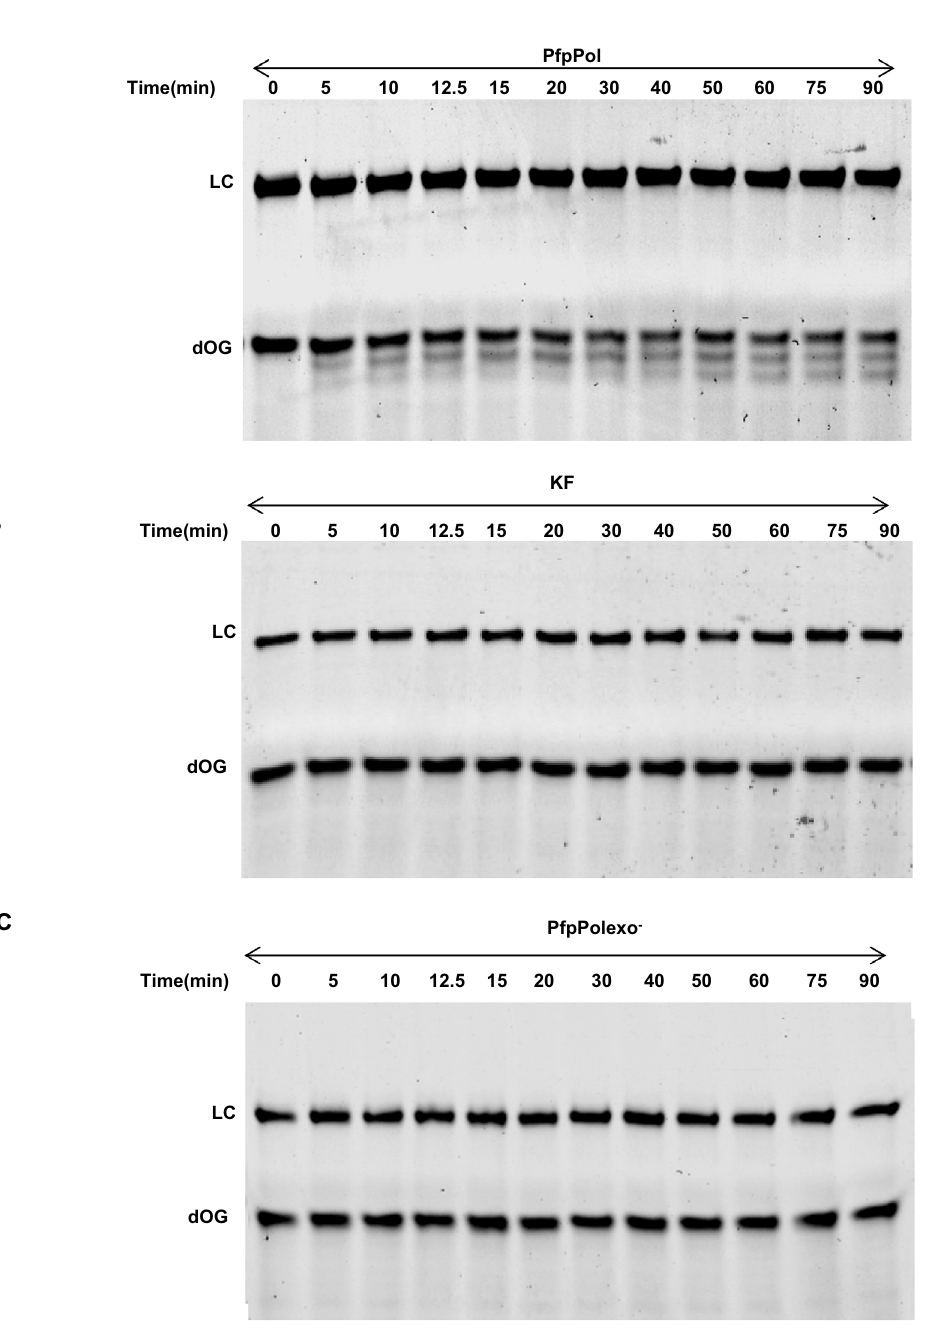
Figure 2. Excision activity on substrate bearing 8oxodGMP at the 3 ′ end. ( A ) 10 nM of PfpPol was incubated with 100 nM of dOG DNA substrate without dNTPs for different time points (0 to 90 min).The exonuclease activity of PfpPol can excise out 8oxodGMP present at the 3 ′ end of the primer opposite template dA. ( B ) 10 nM of KF was incubated with 100 nM of dOG DNA substrate without dNTPs for different time points (0 to 90 min). Unlike PfpPol, the KF enzyme is unable to excise the oxidized nucleotide present at the 3 ′ end of the primer. LC and dOG denote loading control and the DNA substrate with 8oxodGMP at the 3 ′ end, respectively. ( C ) PfpPolexo − was used as a control, and as expected the exonuclease deficient version does not excise 8oxodGMP present at the 3 ′